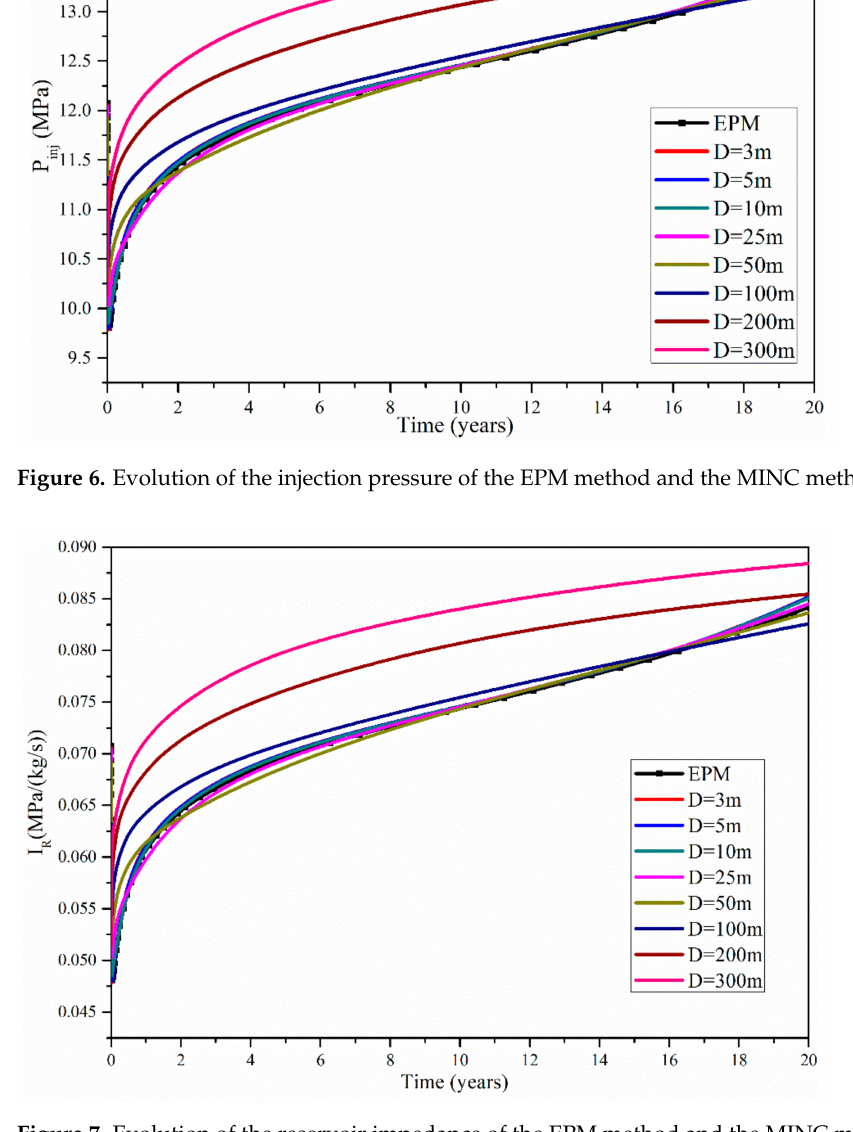
Figure 7. Evolution of the reservoir impedance of the EPM method and the MINC